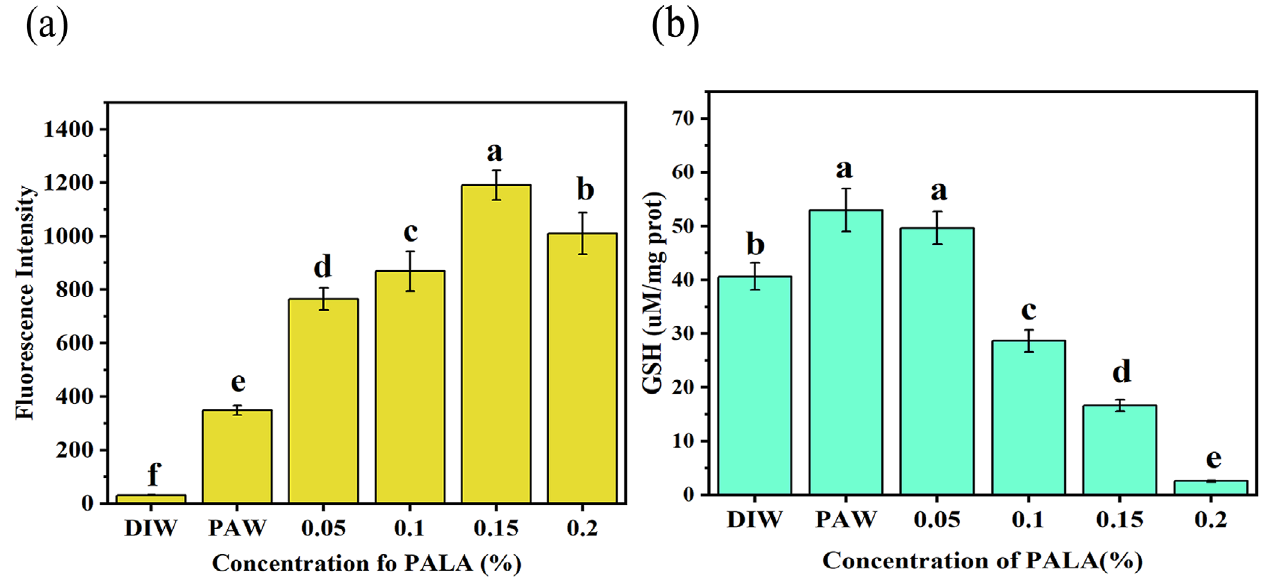
Figure 5. Effect of treatment with DIW, PAW, PALA (0.05%), PALA (0.1%), PALA (0.15%) and PALA (0.20%) on the intracellular ROS levels ( a ) and GSH concentration ( b ) of Pseudomonas Lundensis . Bars represent standard deviations ( n = 3). a–f: values with different lowercase letters significantly differ ( p < 0.05).